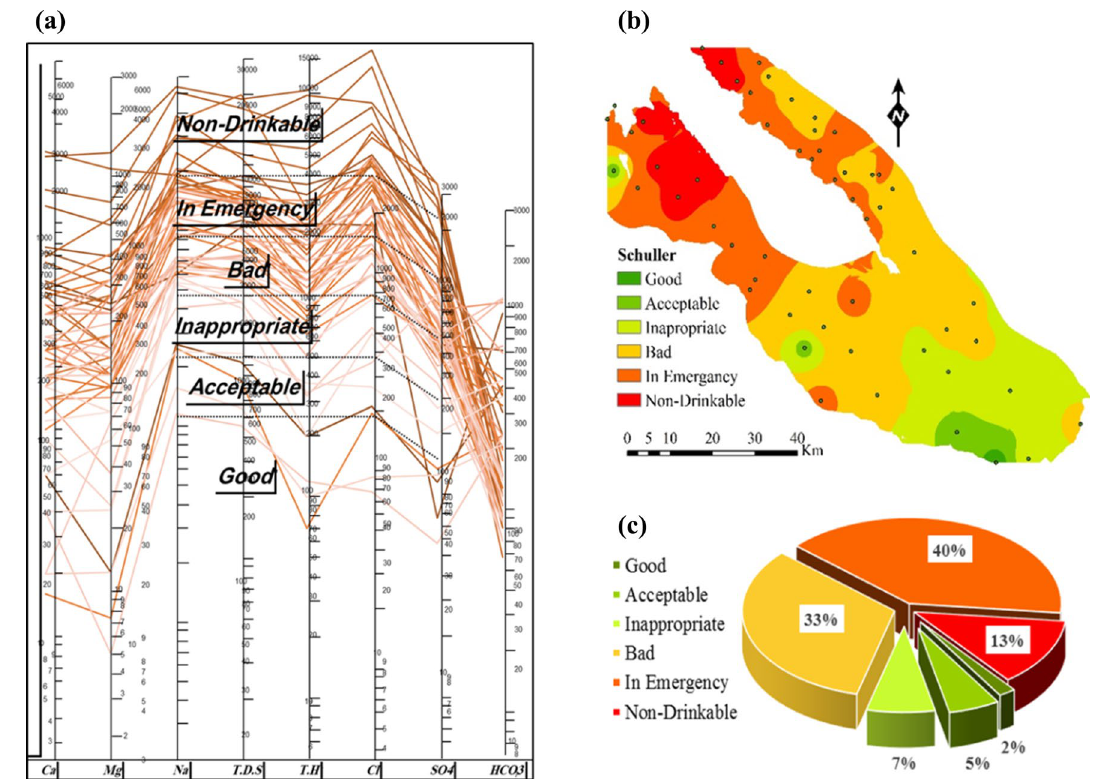
Fig. 10 a Schoeller diagram of 55 drinking water samples and b spatial distribution of its categories; c) percentage of the samples in each cat- egory in the studied